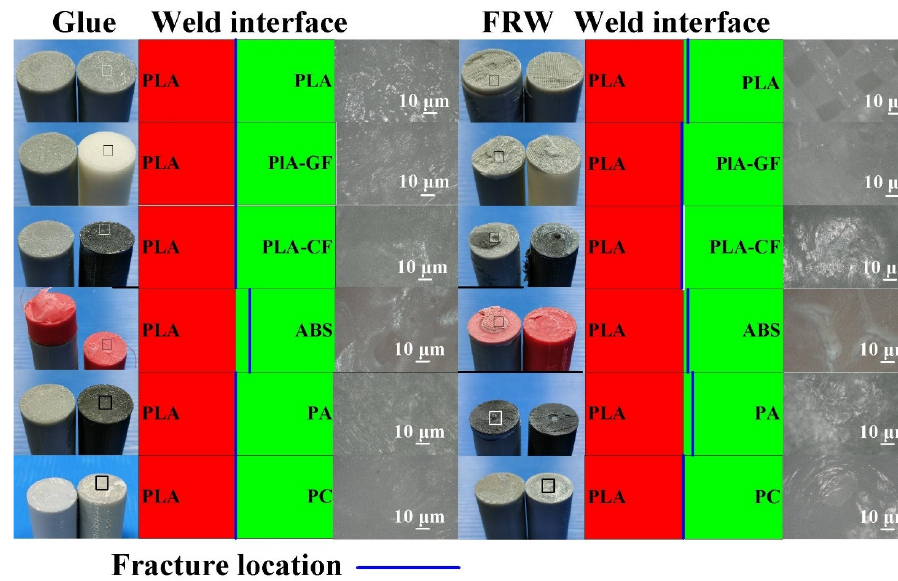
Figure 18. Optical microscopic images of fractured surfaces after bending test.